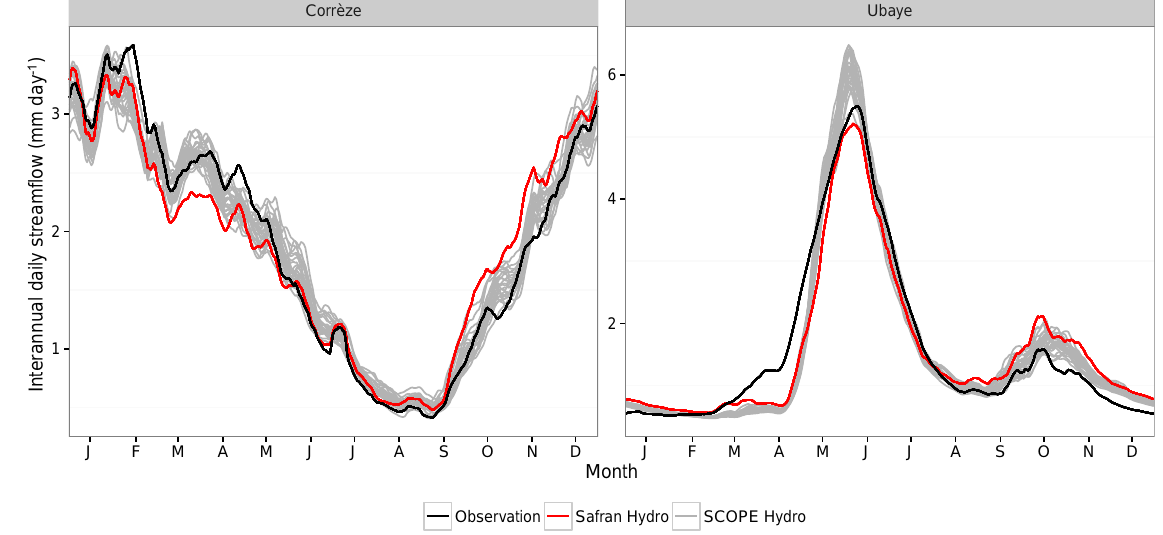
Figure A1. Daily interannual average streamflow – from observations, Safran Hydro, and SCOPE Hydro (see Sect. 3.1) – over the CAL period for the Corrèze and Ubaye rivers, smoothed by a 10-day moving